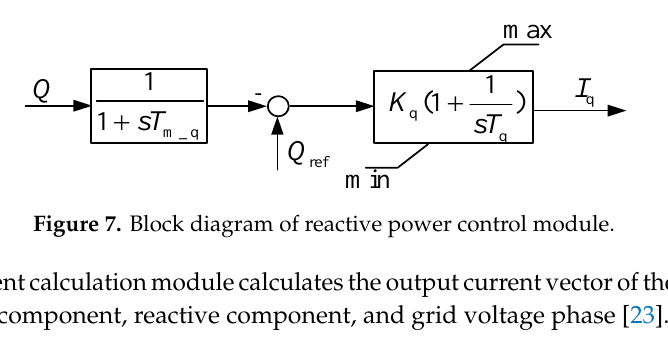
Figure 6. Block diagram of active power control module.